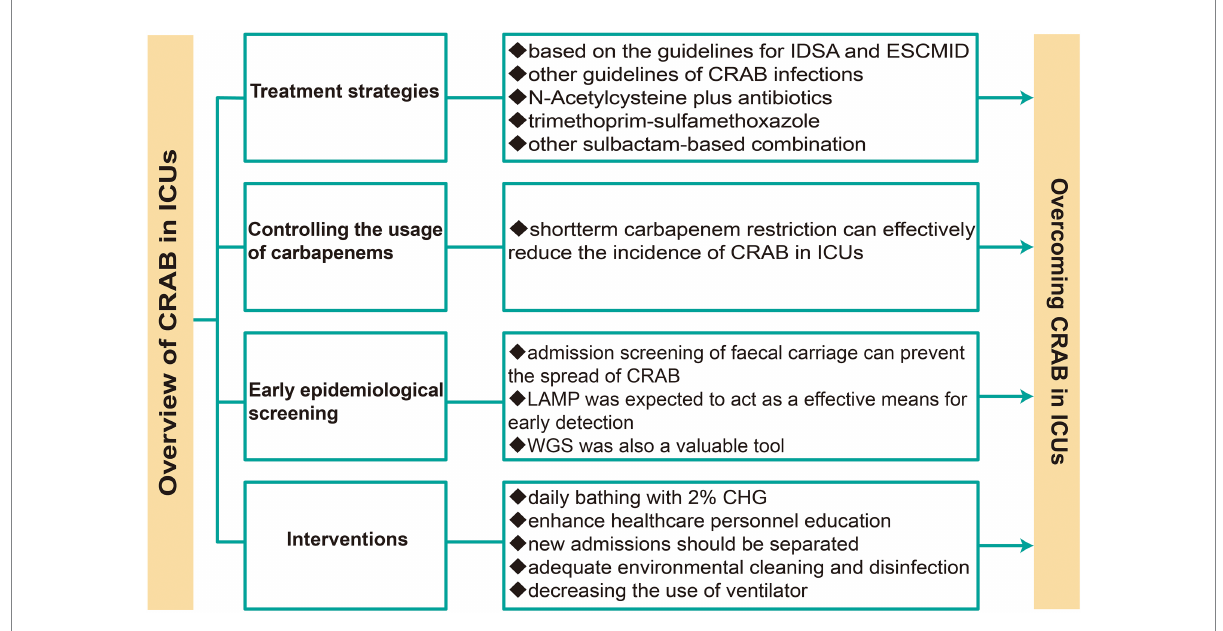
FIGURE 3 Treatment and infection control strategies of CRAB in